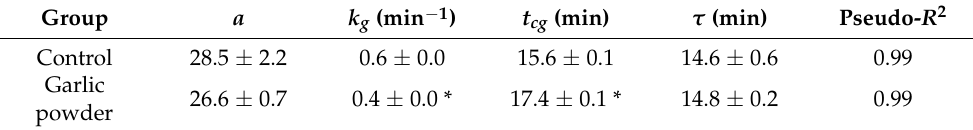
Table 1. Model discrimination results for the logistic-exponential kinetic model in fried potato chips.